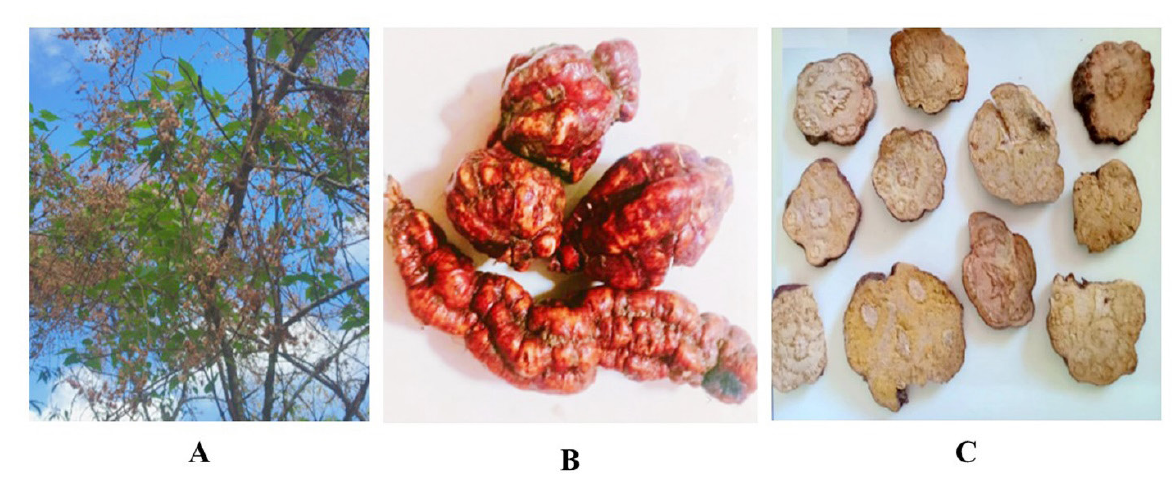
FIGURE 1 - FMT tree and roots A: FMT tree, B: FMT roots, C: Cross section of FMT